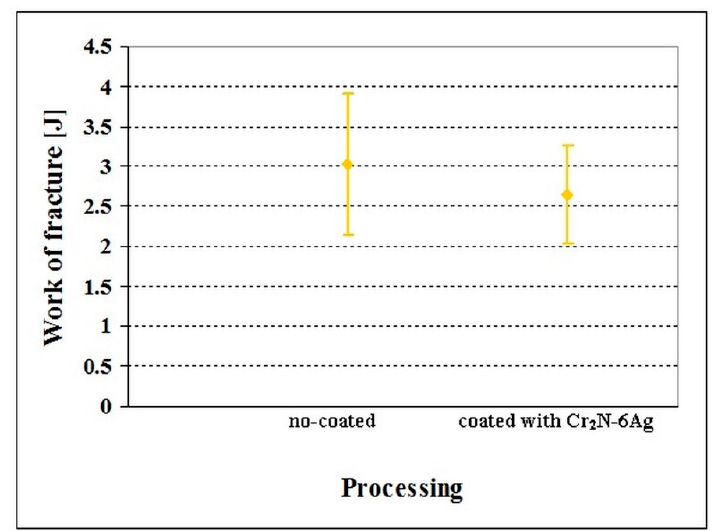
Figure 16. Work of fracture of no-coated and Cr 2 N–6Ag-coated Vanadis 6 steel. The values are adapted from the corresponding literature [59].